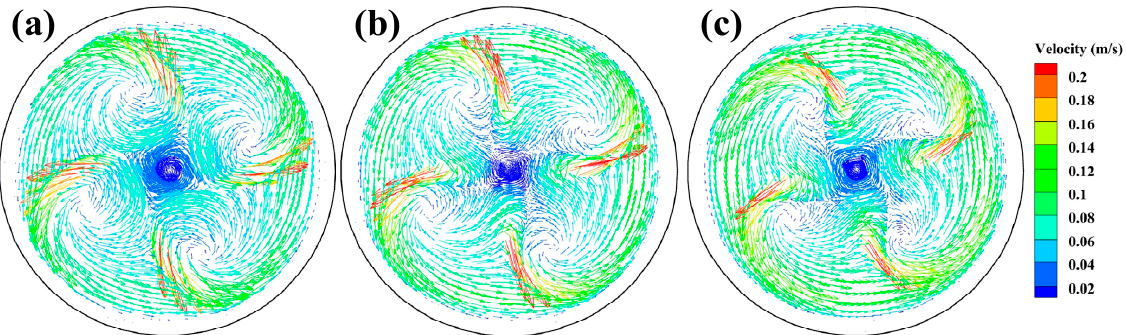
Figure 13. Velocity vector on the plane Z = 0.2 m with M-EMS ( a ) –15° SFN, ( b ) 0° SEN, and ( c ) +15° SFN.